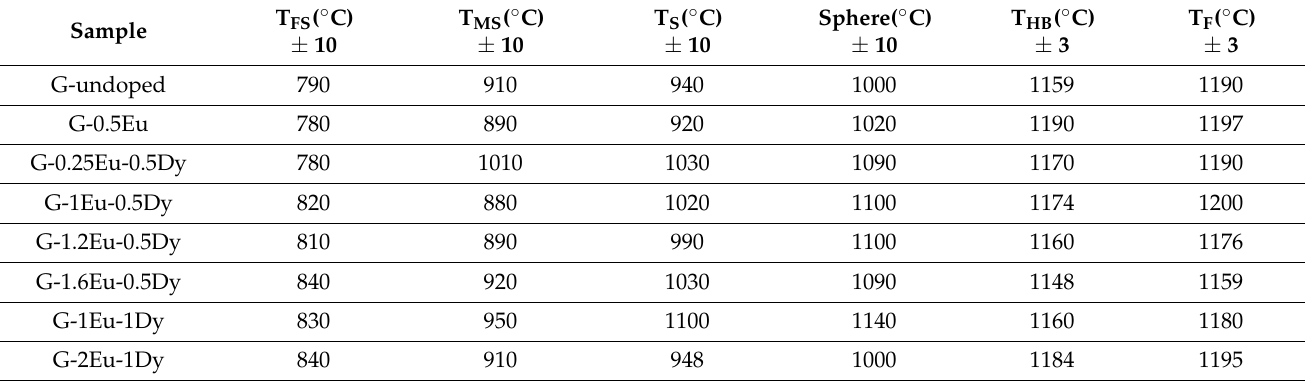
Table 4. Sintering and flow temperatures of glass (ø <20 µ m) samples determined with HSM.